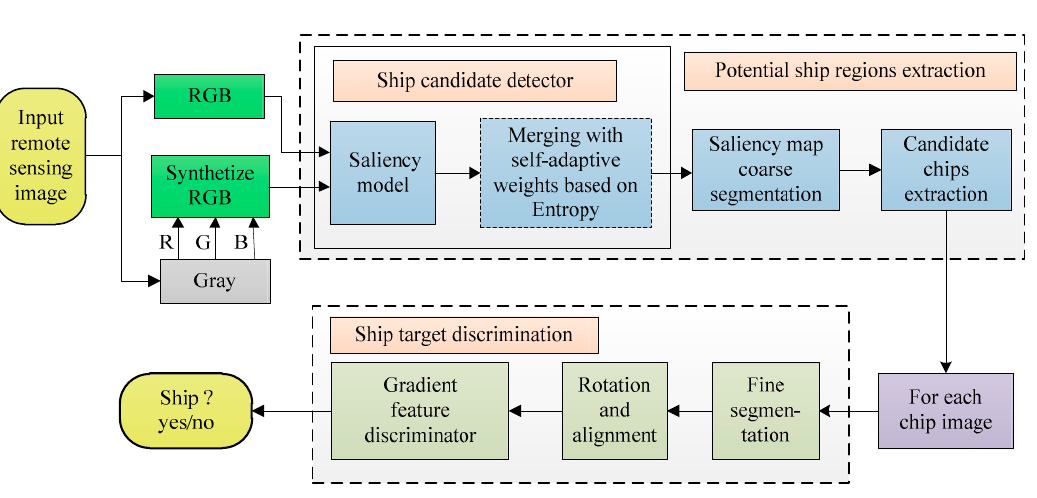
Figure 1. Diagram of the proposed ship detection scheme.